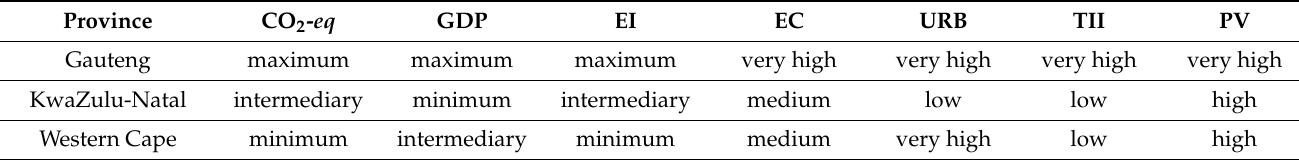
Table 5. Econometric comparison of variables characteristic within the three